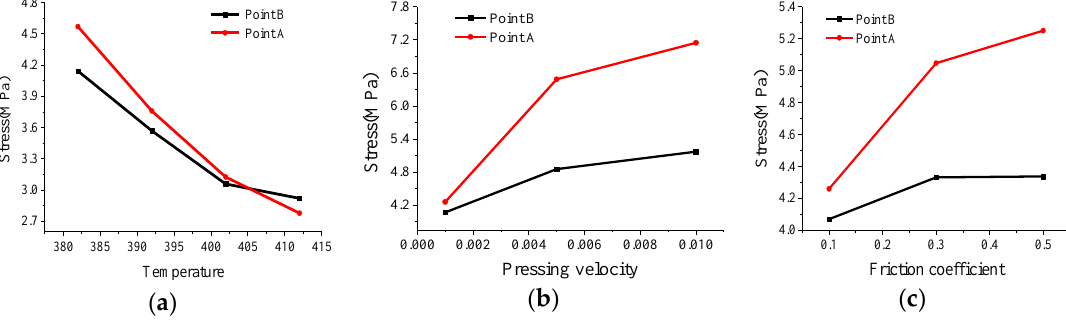
Figure 14. Effect of process parameters on stresses of ChG: ( a ) temperature, ( b ) pressing velocity, and ( c ) friction coefficient [30].